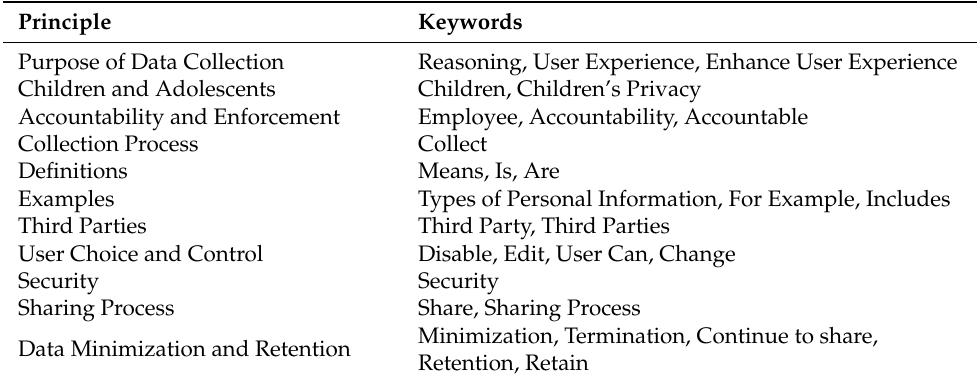
Table 2. Keywords and phrases used in